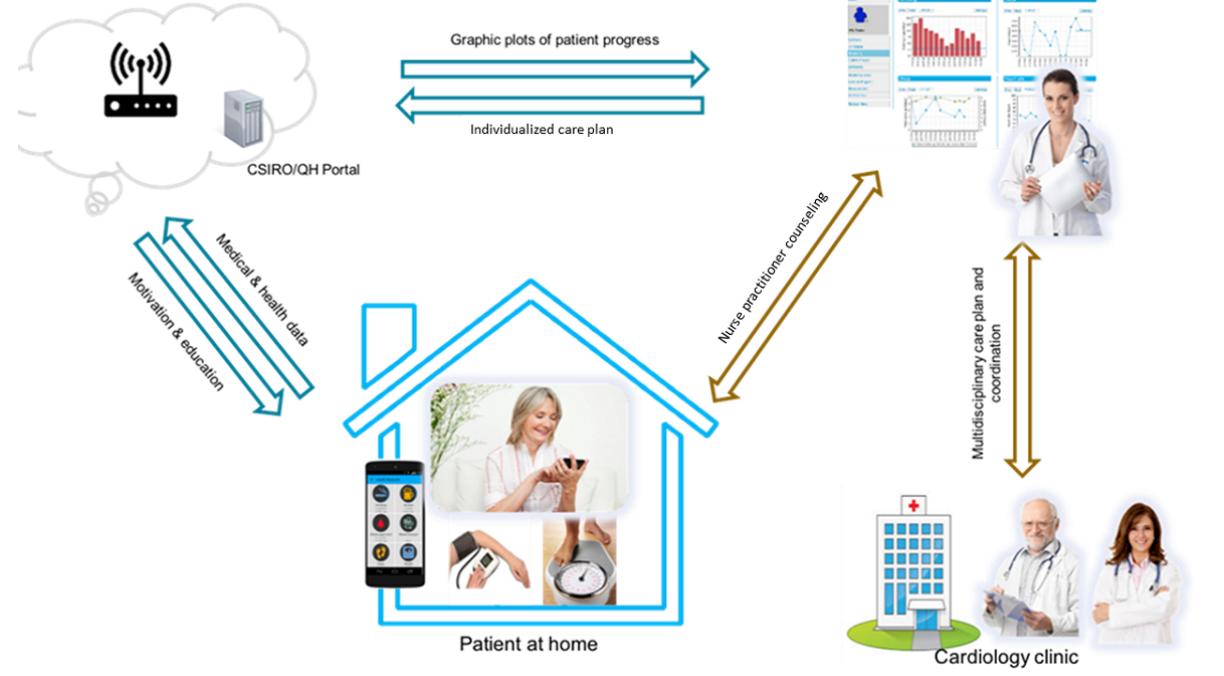
Figure 1. MoTER-ACS platform. CSIRO: Commonwealth Scientific and Industrial Research Organisation; MoTER-ACS: Mobile Technology–Enabled Rehabilitation for Patients With Acute Coronary Syndrome; QH: Queensland Health.